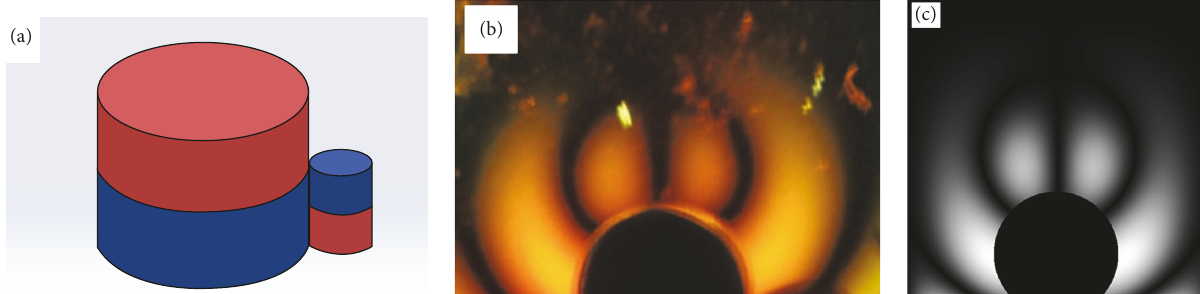
Figure 6: The magnetic field of two cylindrical magnets, placed side by side with poles in opposition, as it is shown in the diagram (a), one magnet with 900 Gauss and the small one with 200 Gauss. The pattern obtained with the Ferrocell is shown in (b) with the small magnet at the bottom. (c) presents the simulation for this compound magnet.